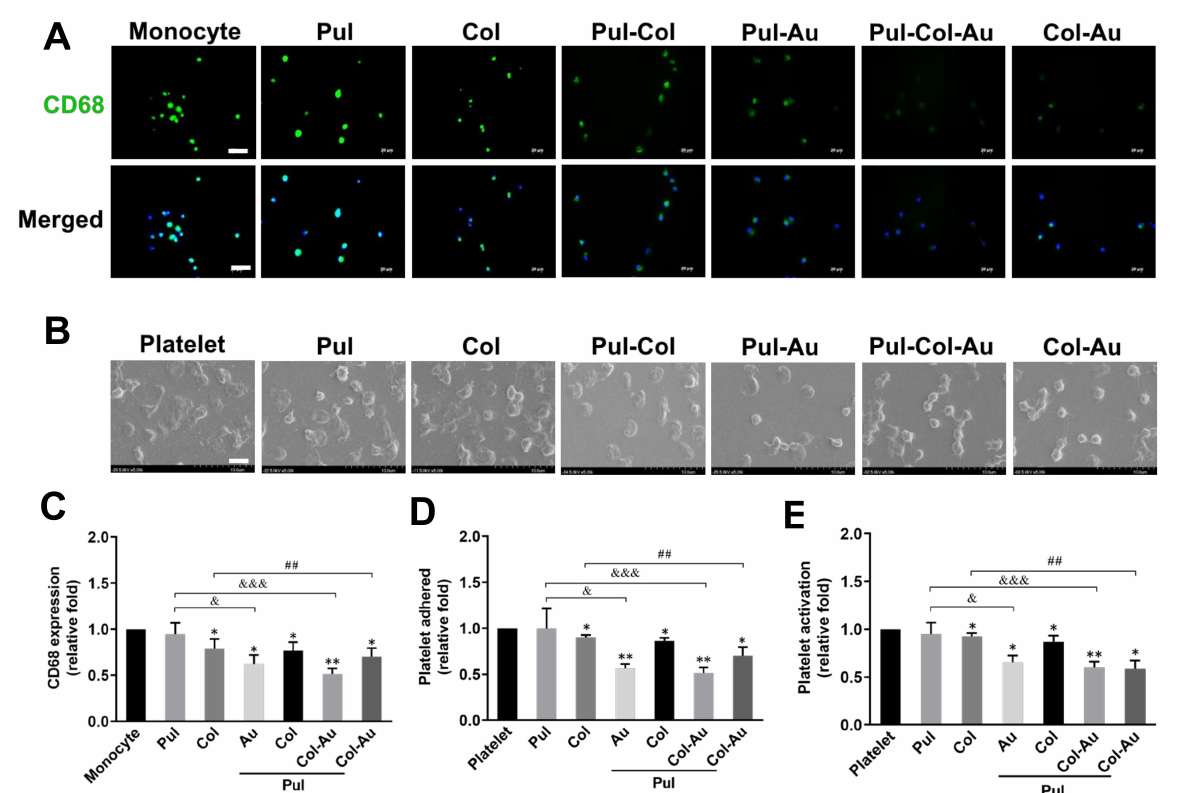
Figure 4. Effects of various materials in macrophage and platelet activation. ( A ) The macrophage marker CD68 (green color) was investigated by immunofluorescence staining at 96 h. DAPI was used to locate cell nuclei (blue color). Scale bar = 20 µ m. ( B ) The morphology of platelets was observed by SEM analysis. Scale bar = 10 µ m. ( C ) The CD68 positive cells were semi-quantified for macrophage activation. The results indicate the lowest expression was in Pul–Col–Au group. ( D , E ) The platelet adherence efficiency and degree of platelet activation were further quantified. The data also demonstrated that the lowest platelet adherence and activation was in the Pul–Col–Au group. Data are exhibited as mean ± SD of the three independent experiments. * p < 0.05, ** p < 0.01: compared to monocyte or platelet alone group. & p < 0.05, &&& p < 0.001: compared to Pul group. ## p < 0.01: compared to Col